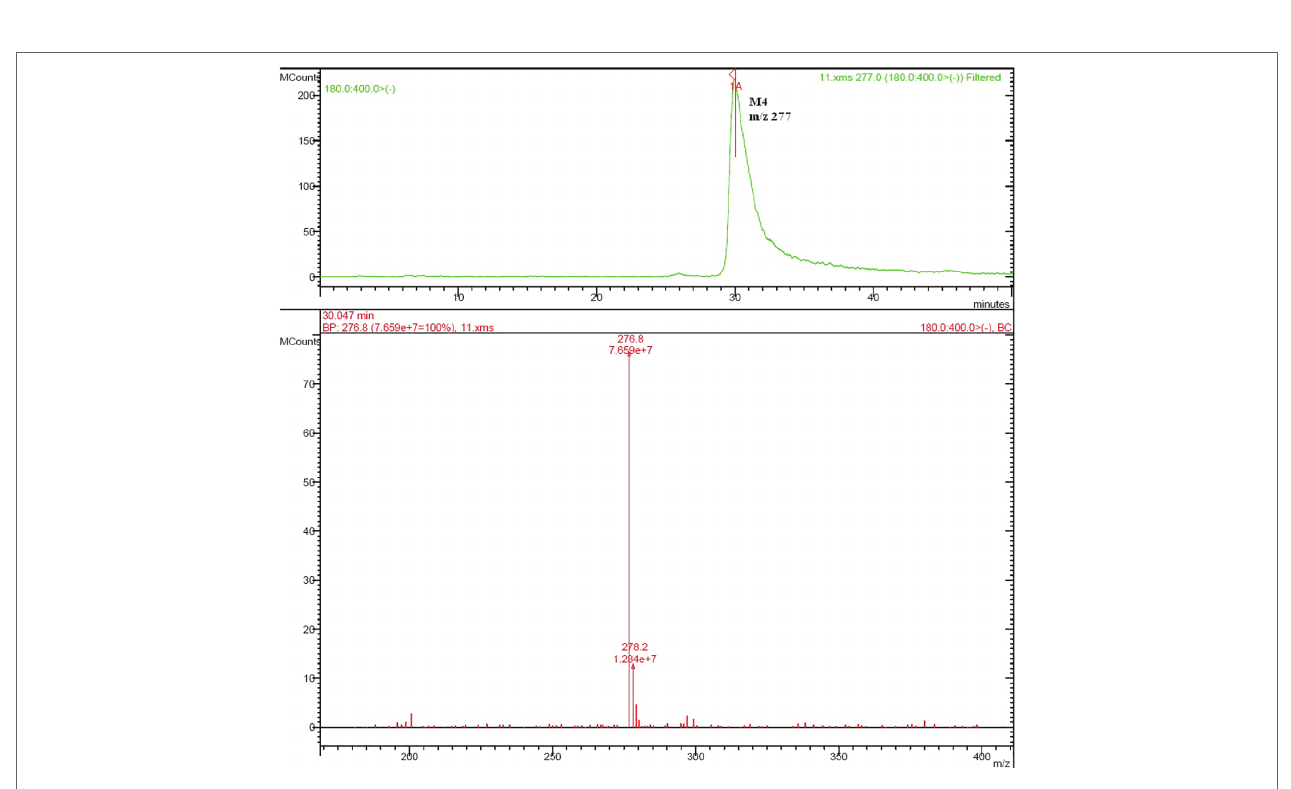
FIGURE 6 | EIC of rat urine sample at m/z